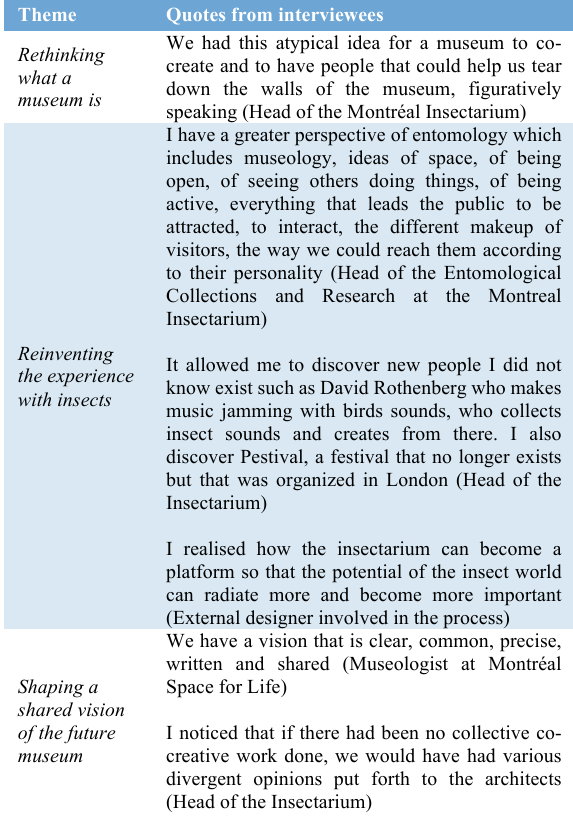
Table 1. How experimenting with collaborative